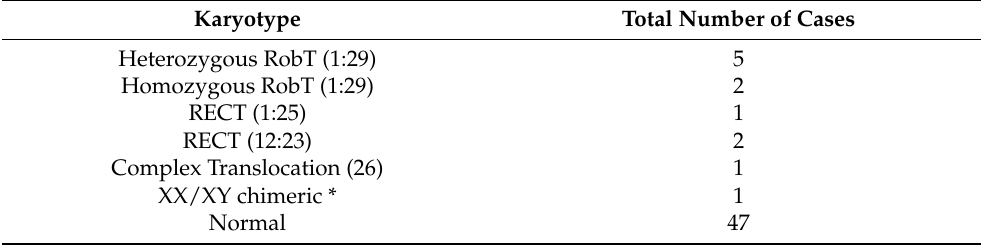
Table 1. Chromosomal errors detected by FISH screening among n = 59 individuals. RobT = Robertsonian translocation; RECT = Reciprocal translocation. * Chimeric bull 10 cell analysed 50:50